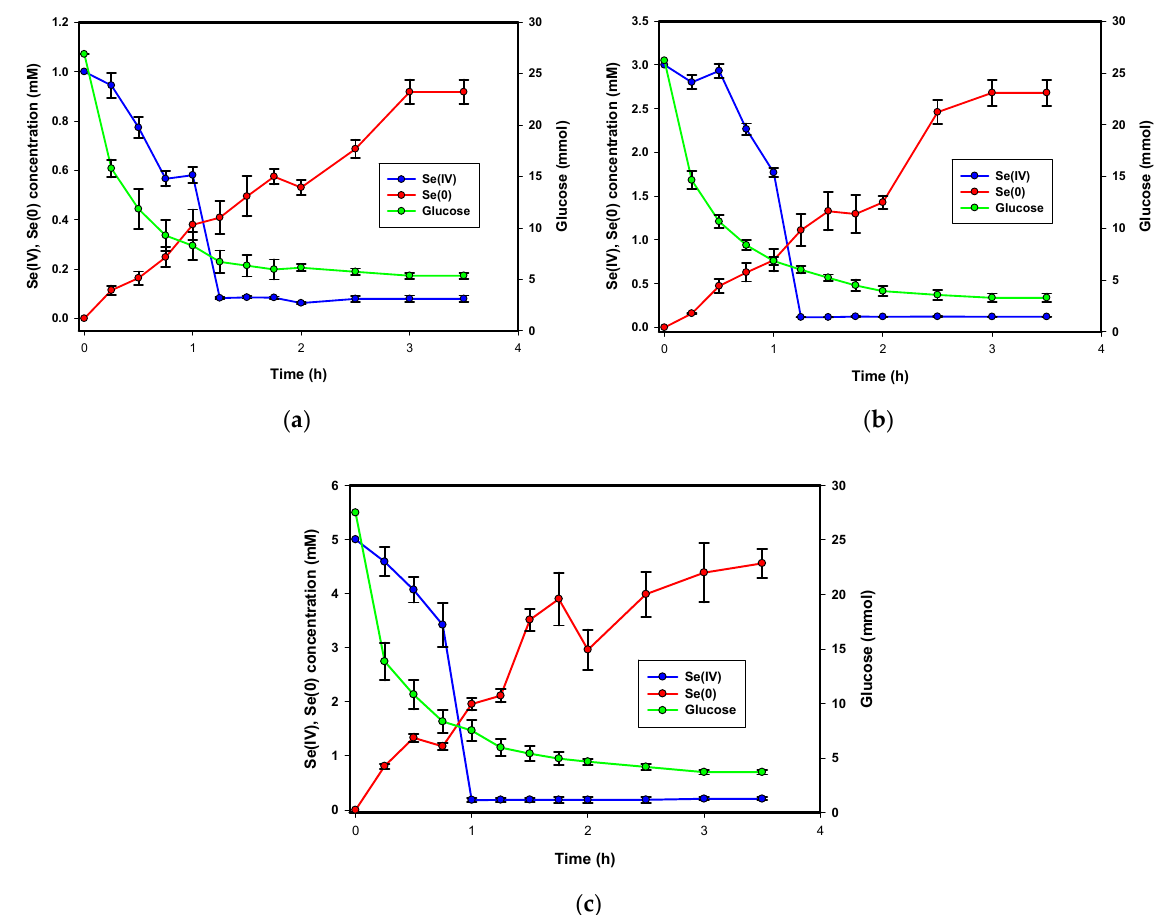
Figure 4. Time courses showing SeO 32 − reduction, Se 0 formation and glucose utilisation for ( a ) 1 mM, ( b ) 3 mM and ( c ) 5 mM concentrations, respectively.